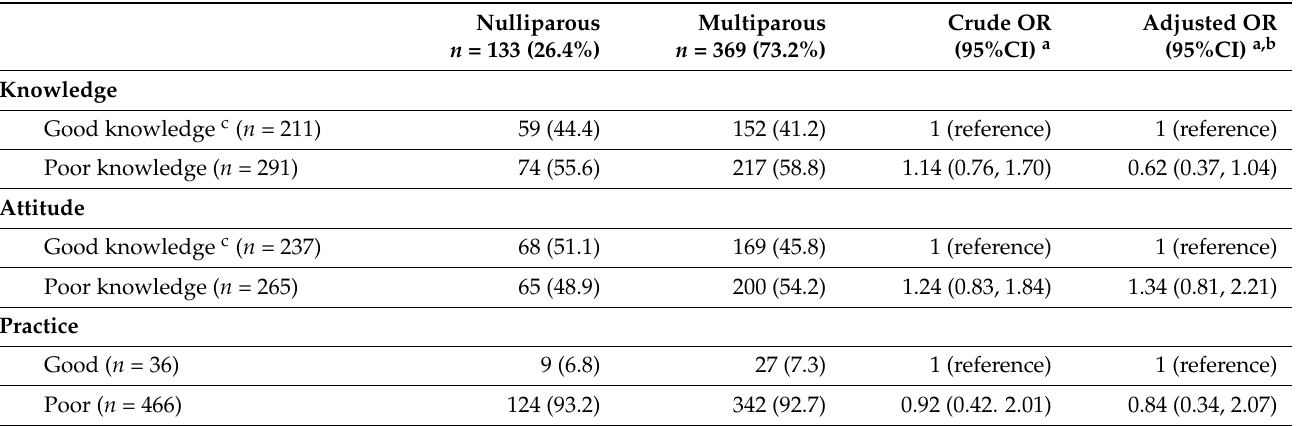
Table 3. Associations between knowledge, attitude, and practice towards pelvic floor muscle exercise and parity for pregnant women in Gondar, Ethiopia. n =